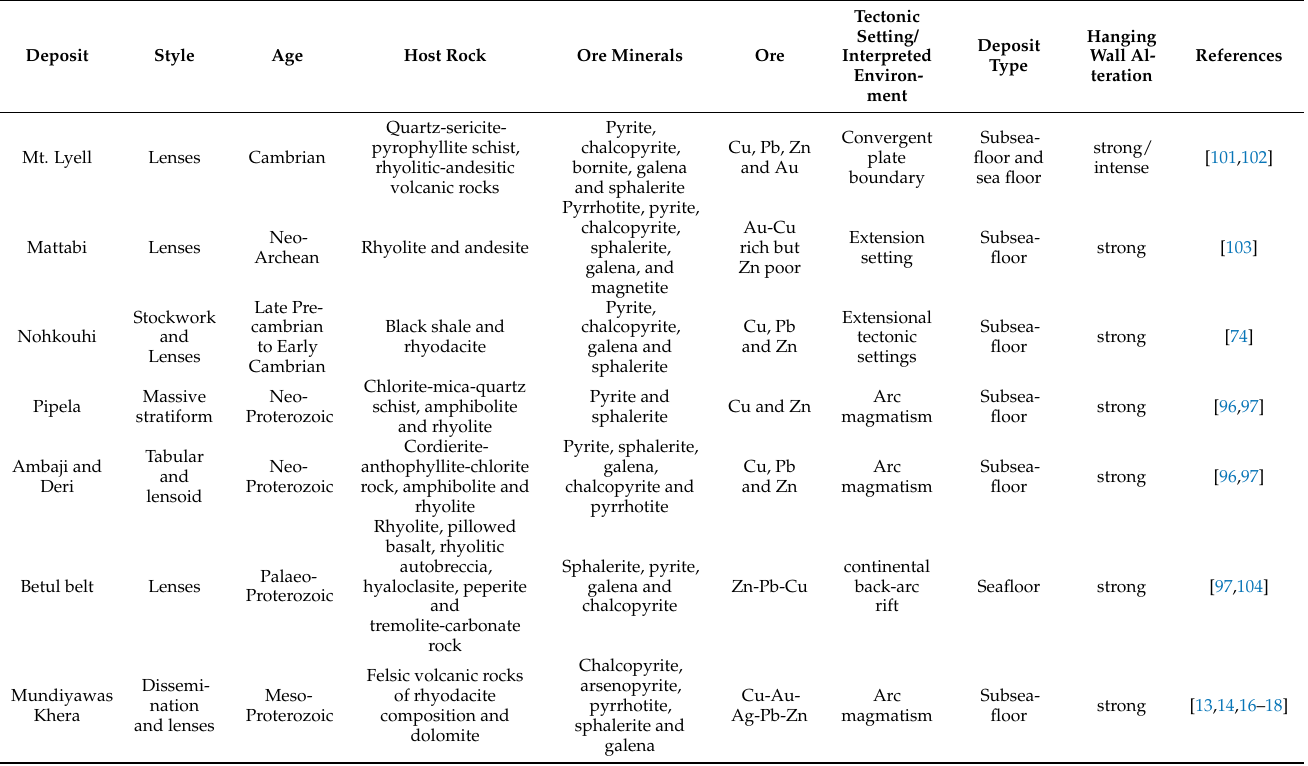
Table 2. A comparison status of felsic volcanic hosted VMS deposit in a global scenario with similarities and dissimilarities in lithological, mineralogical and tectonic